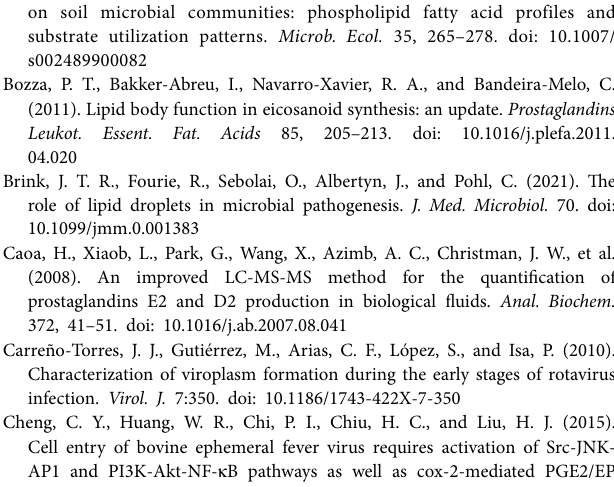
Supplementary Figure S1 | Cellular toxicity of the inhibitors and DMSO was evaluated with the XTT assay. MA104 cells (4 × 104 cells/ml) were seeded into 96-well plates and allowed to grow to 100% confluence. The inhibitors were added 1 h prior to infection and subsequently every 4 h till the completion of the experiment. (A) All inhibitors were added to MA104 cells containing a final concentration of 1% DMSO to ensure the vehicle had no detrimental effect on the cells. Results indicate that 1% decreases cell viability to approximately 92 ± 3%. (B) Data obtained from the toxicity assays. Concentrations to be used for the different inhibitors were determined as follows: indomethacin 25 μM (84% ± 0.19), celecoxib 5 μM (85% ± 0.85), SC-560 2.5 μM (83% ± 1.5) and CAY10502 25 nM (93% ± 2.8). Supplementary Figure S2 | Mass spectra showing the five transitions (Multiple reaction monitoring) for each of the samples. Only one transition of PGE2 is present in the mock infections at (A) 2 h and (B) 4 h. All five the transitions of PGE2 are present in cells infected at a MOI 0.1 (C,D) and 1 (E,F) at 2 h (C,E) and 4 h (D,F) post-infection, respectively. Furthermore, all five the transitions of PGE2 are present in cells infected at a MOI of 10 t (G) 2 h and (H) 4 h post-infection. Due to very low signal to noise ratios, the LC-MS/MS data were only used to verify the presence of PGE2. Peaks show the relevant transitions 351.17 > 315.2; 351.17 > 271.2; 351.17 > 333.3; 351.17 > 189.0; and 351.17 > 235.1. Prostaglandin E2